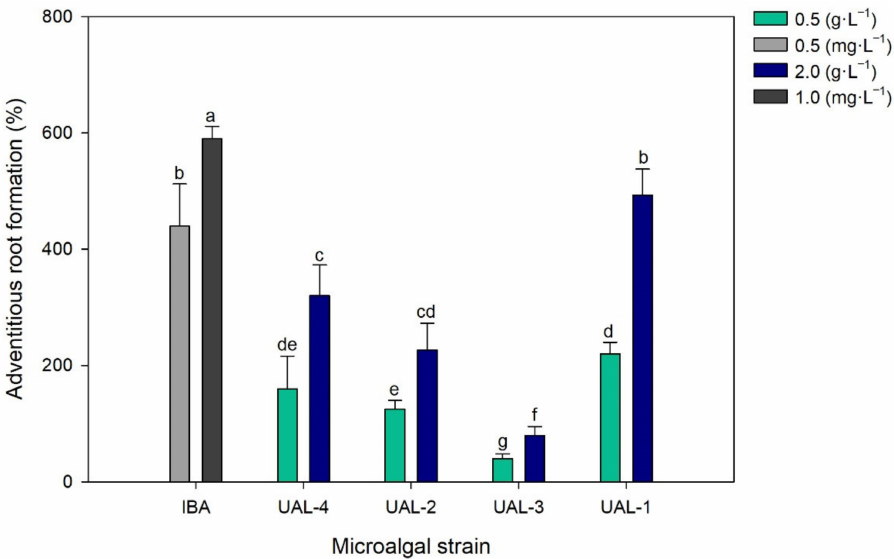
Figure 4. Effect of the microalgal extracts on the formation of adventitious roots. Values represent the percentage of variation with respect to the control (distilled water). Values represent the mean values ± SD. Different letters indicate significant differences ( p <